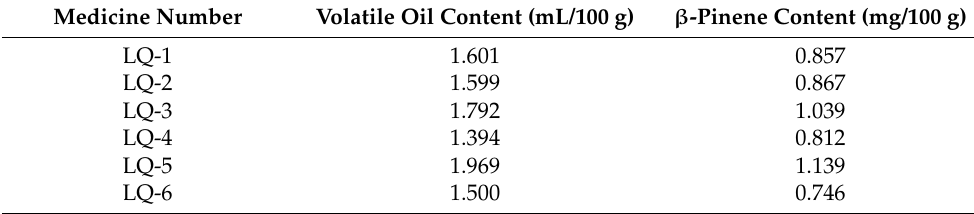
Table 8. Characterization of raw material properties of different batches of F. suspensa